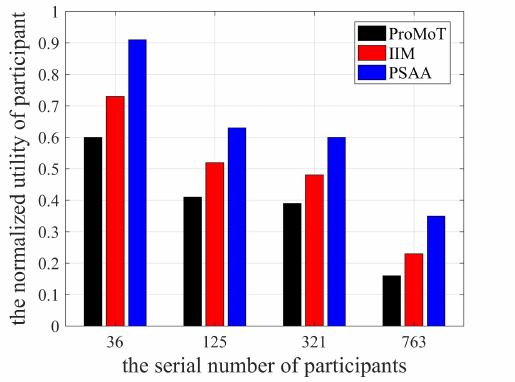
Figure 3. The utility of